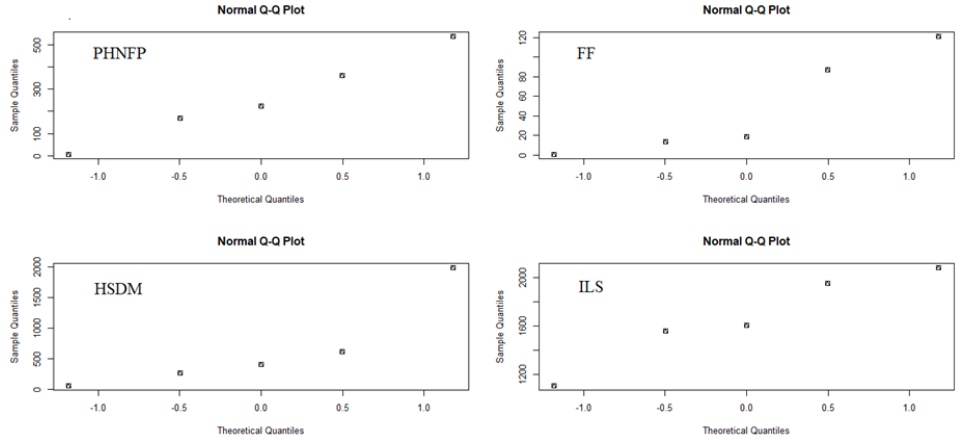
Figure 21. Normality graphs for PHNFP, FF, HSDM, and ILS algorithms.